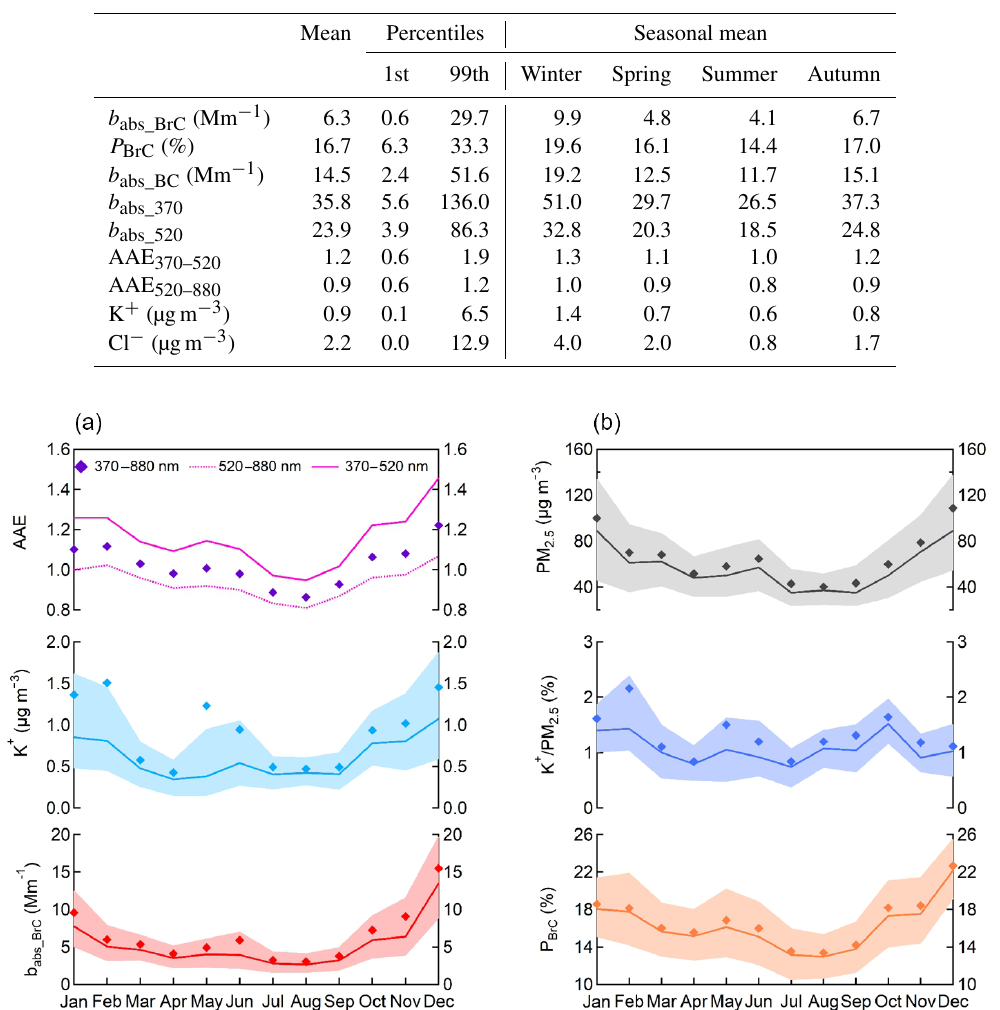
Figure 5. Seasonal cycle of (a) b abs_BrC , K + , and AAE at different wavelength ranges (AAE 370–520 , AAE 370–880 and AAE 370–880 , shown by the solid line, dashed line and diamonds, respectively) and (b) P BrC , K + / PM 2 . 5 and PM 2 . 5 . For b abs_BrC , K + , P BrC , K + / PM 2 . 5 and PM 2 . 5 figures, bold solid lines represent median values, diamonds show the monthly averages and thin solid lines forming the shaded area are 25th and 75th